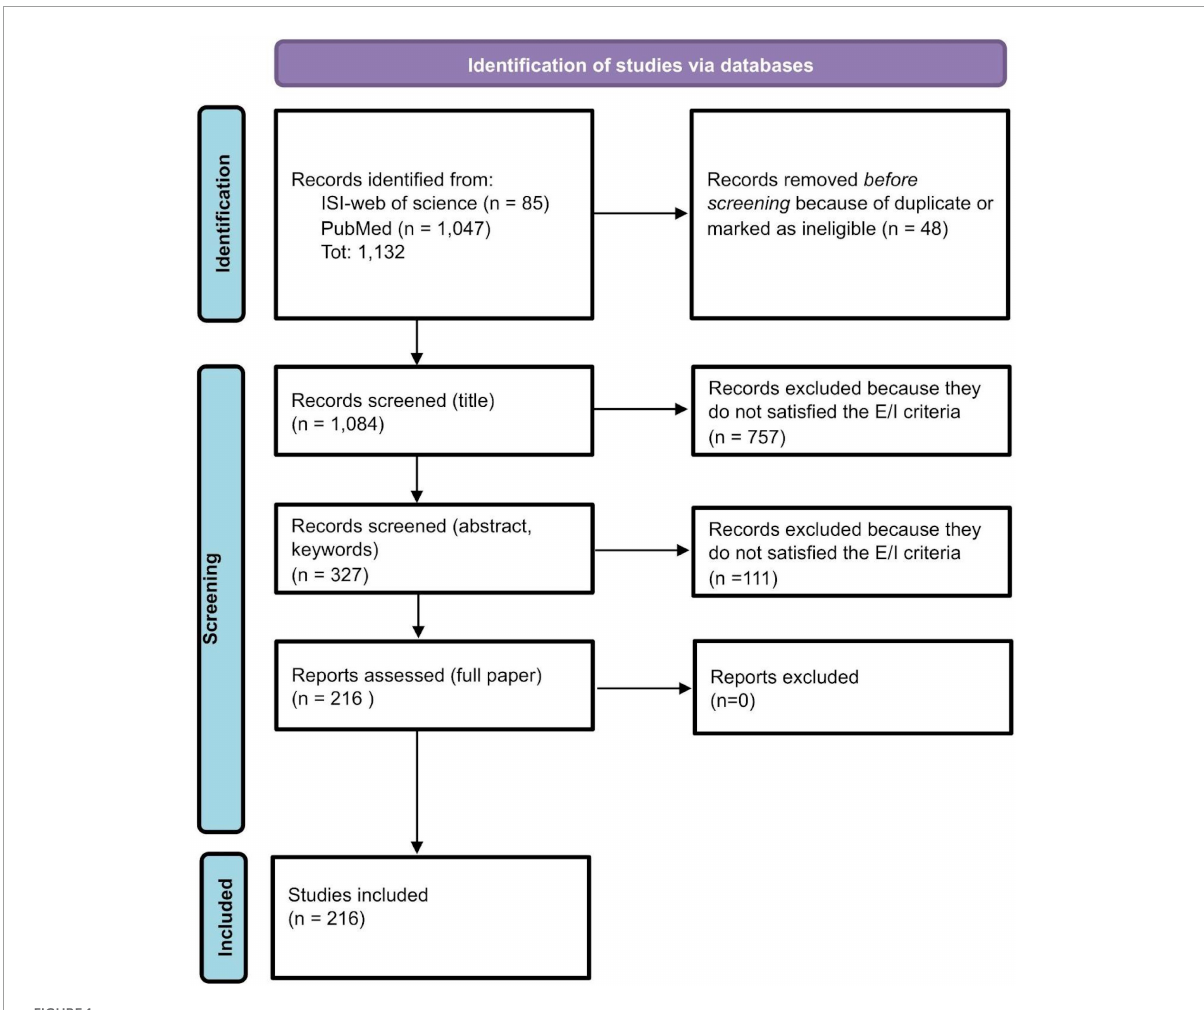
FIGURE1 Review process: PRISMA flow-chart